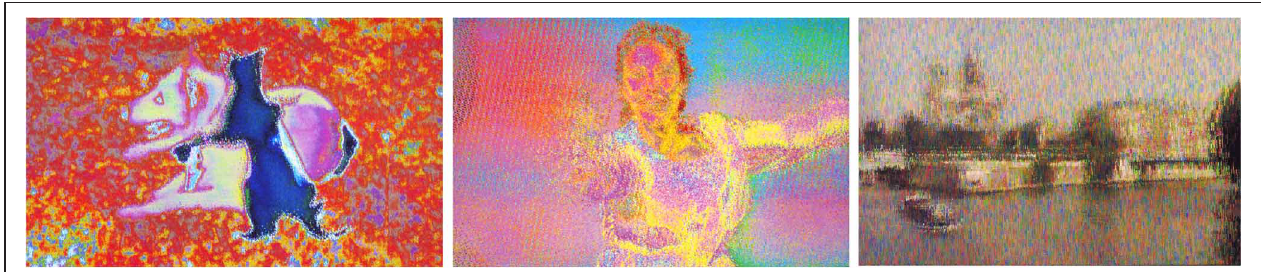
FIGURE 3 | Image reconstructions from dreams using a dream decoder in the Wim Wenders film “Until the end of the world” (1991). “Dog and cat,” “Woman running,” and “Paris,” Wim Wenders